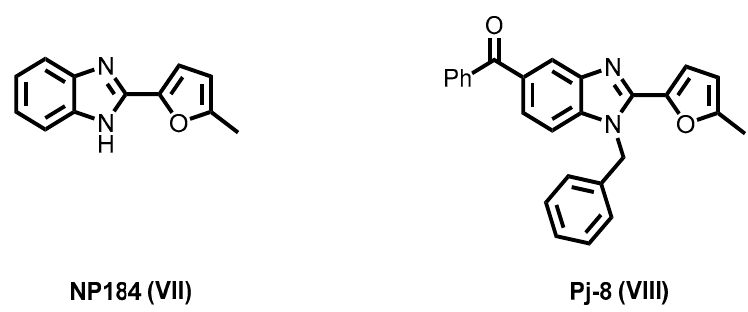
Figure 3. 2-Furyl benzimidazoles VII and VIII of potent antiangiogenic activity.